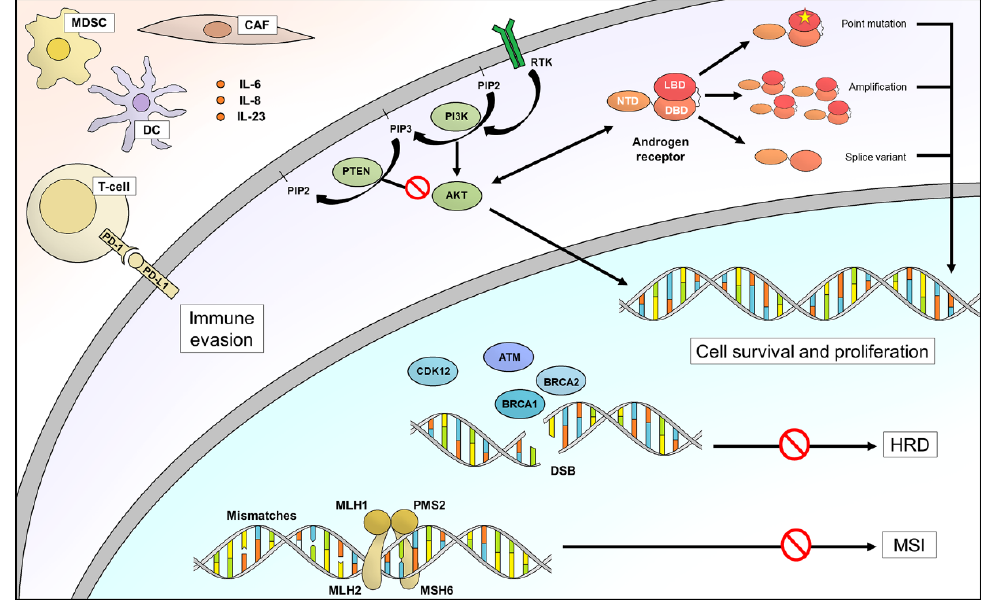
Figure 1. Predictive and prognostic biomarkers in prostate cancer. DC, dendritic cell; CAF, cancer associate fibroblast; MDSC, myeloid-derived suppressor cells; RTK, receptor tyrosine kinase; DSB, double strand break; HRD, homologous recombination deficiency; MSI, microsatellite instability. Table 1. Predictive and prognostic biomarkers in mCRPC. mCRPC: metastatic castration-resistant prostate cancer.